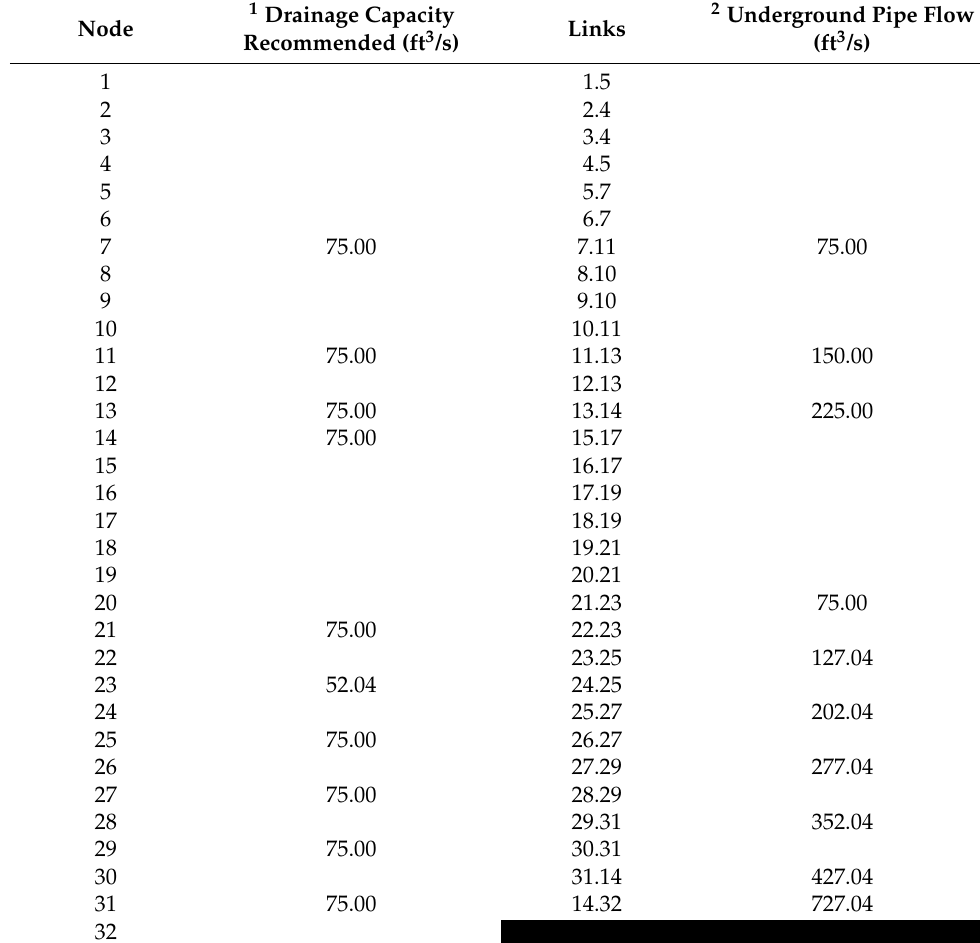
Table 4. Optimized values for Whittier, NC watershed (analysis for 100-year